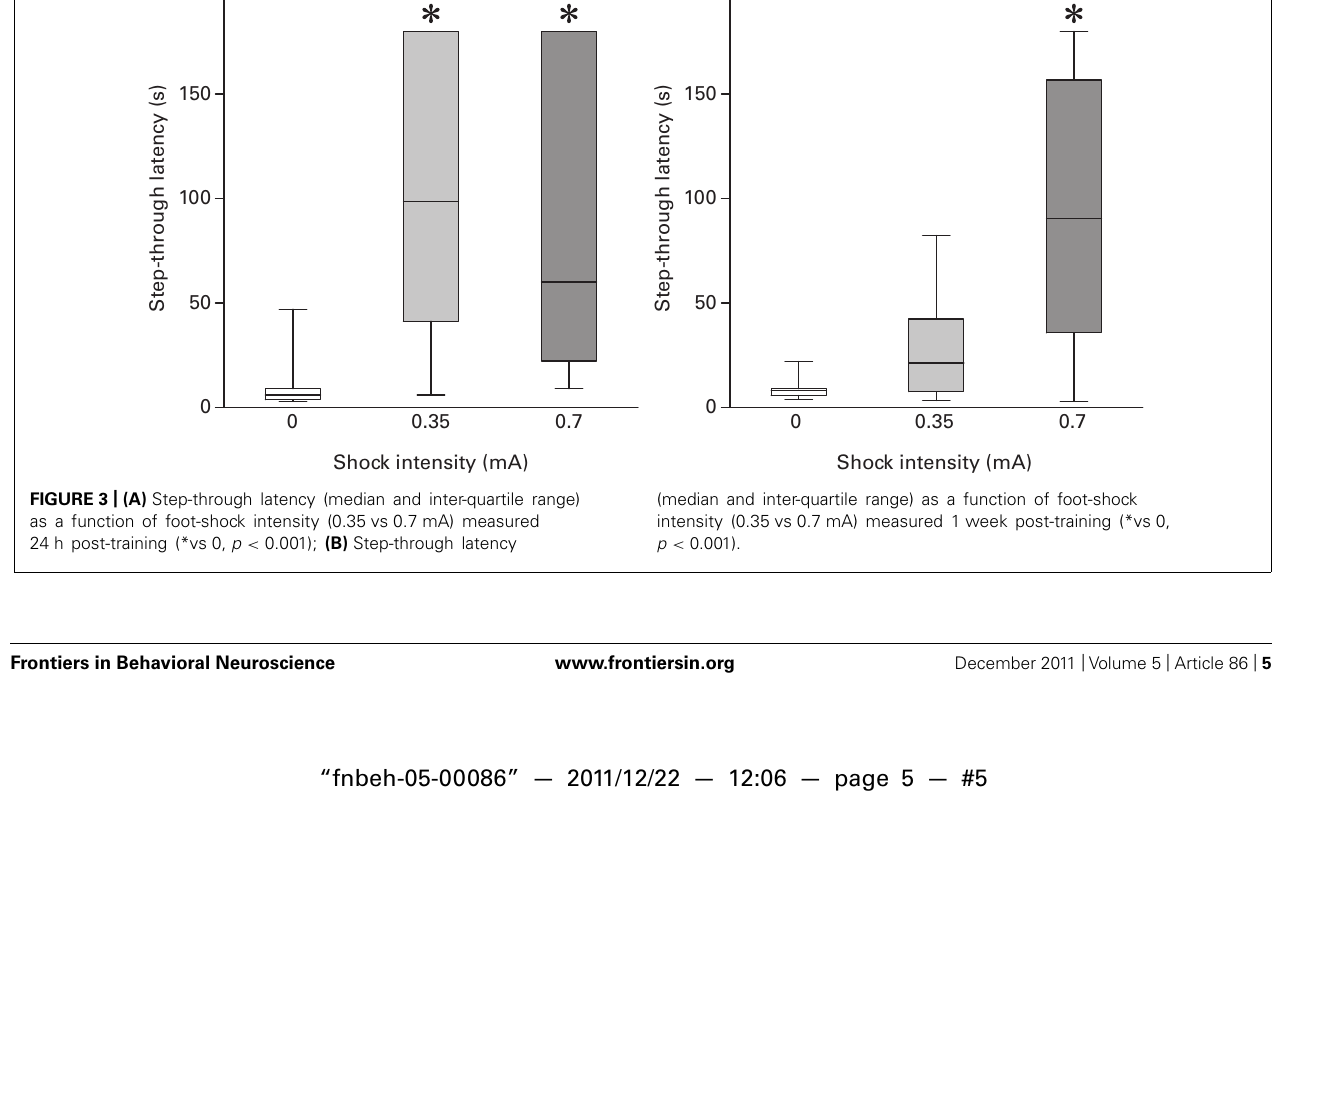
FIGURE 3 | (A) Step-through latency (median and inter-quartile range) as a function of foot-shock intensity (0.35 vs 0.7 mA) measured 24 h post-training (*vs 0, p < 0.001); (B) Step-through latency